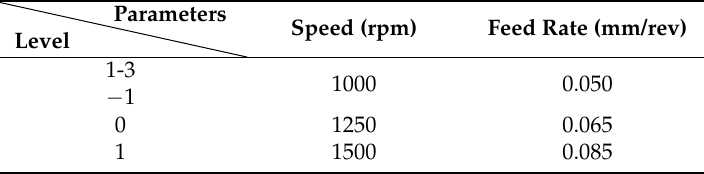
Table 1. Cutting parameters and their levels in experiments. 186